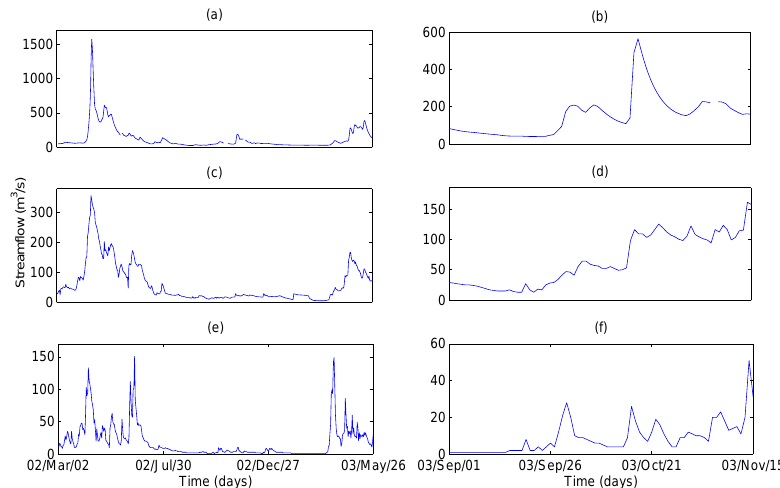
Fig. 4. Hydrograph for (a) Ceizur, calibration, (b) Ceizur, validation, (c) Maniwaki, calibration, (d) Maniwaki, validation, (e) Chelsea, calibration and (f) Chelsea, validation. Calibration data is from 2 March 2002 to 15 July 2003 and validation data is from 1 September 2003 to 17 December